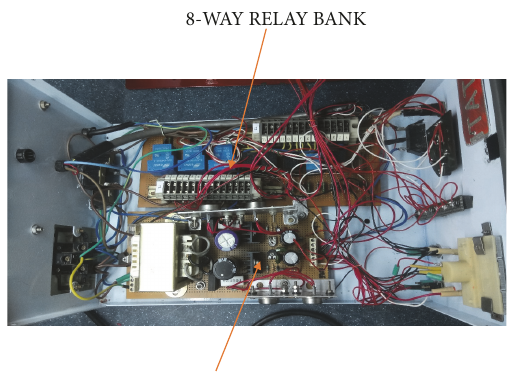
Figure 12: Internal features of PTS controller unit designed and constructed.